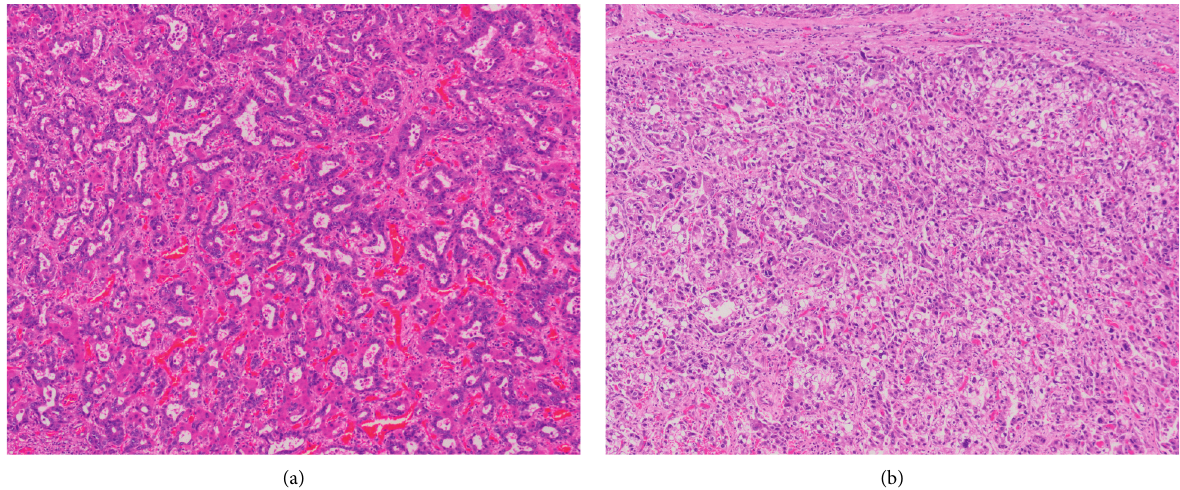
Figure 1: The tumour showing mixed morphologic features with haphazardly arranged, irregularly shaped glands enmeshed in fibrotic stroma typical of cholangiocarcinoma (a) as well as sheet-like growth of solid cell nests and trabeculae showing morphologic and im- munohistochemical evidence of hepatocellular differentiation